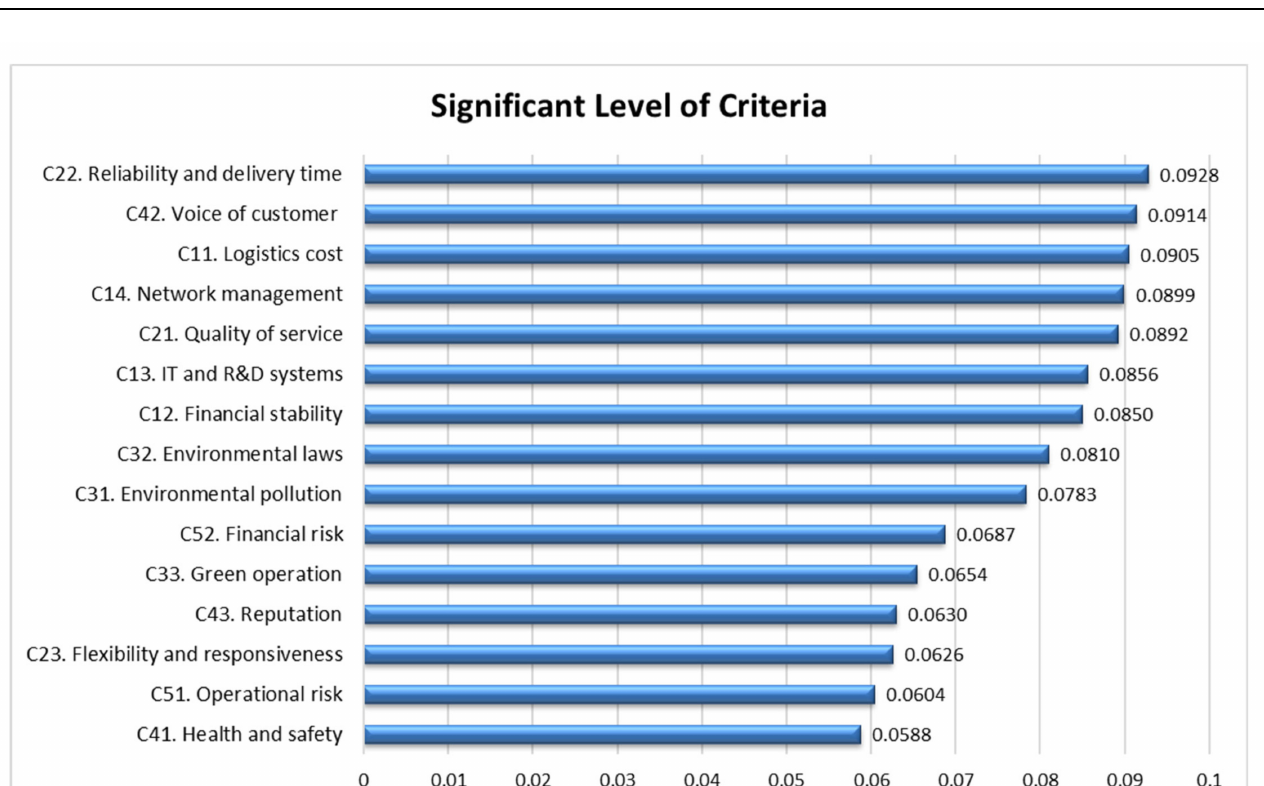
Figure 4. The relative significant level of criteria of FAHP